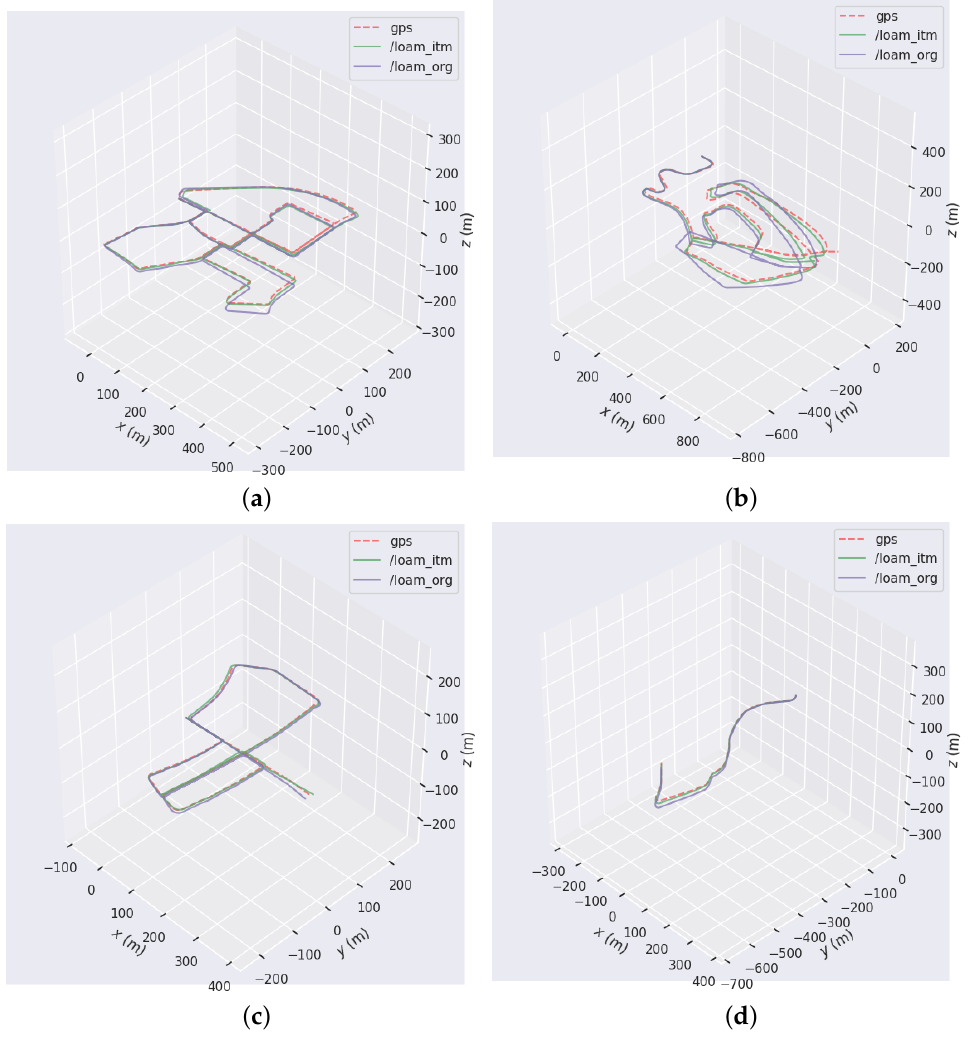
Figure 11. Comparison of Mapping Results with and without ITM Using KITTI Dataset. ( a ) KITTI Dataset 00. ( b ) KITTI Dataset 02. ( c ) KITTI Dataset 05. ( d ) KITTI Dataset